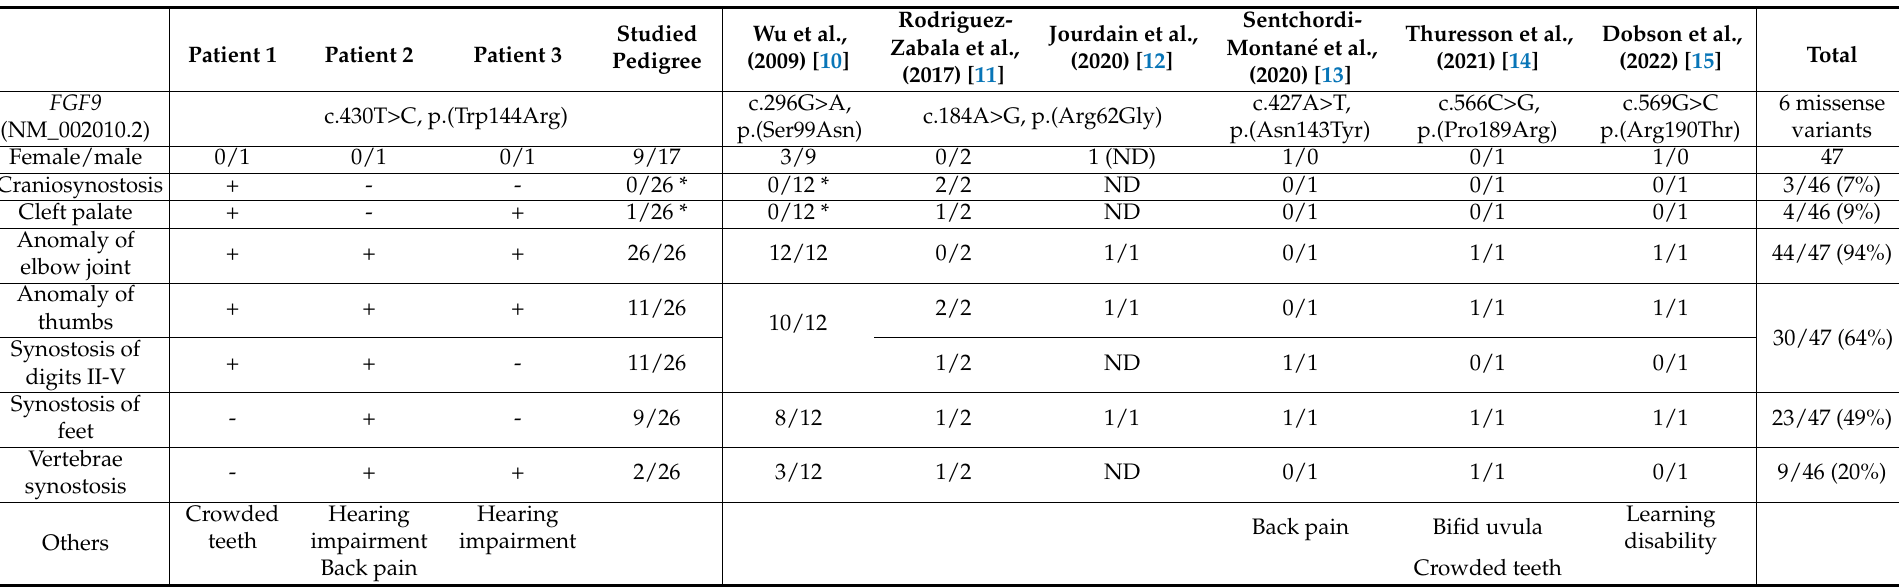
Table 1. Summary of the phenotypic traits seen in the described patients, the studied pedigree and the available